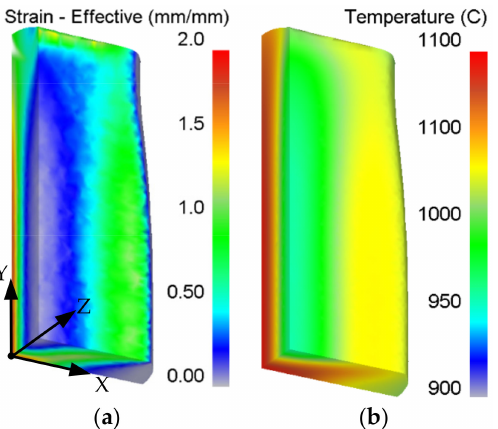
Figure 14. Simulation results of effective strain and temperature after compression. ( a ) Effectively strain, ( b )